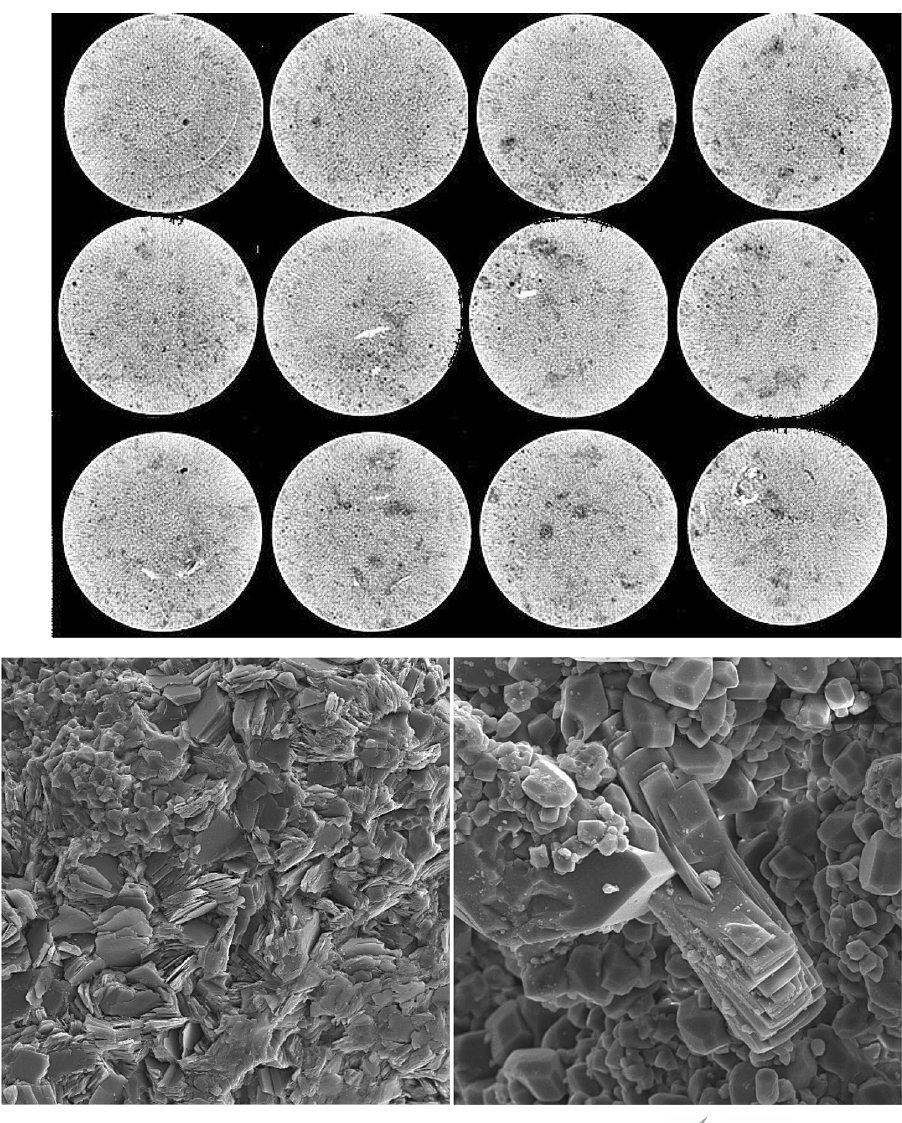
Fig. 8 CT images of core no.2